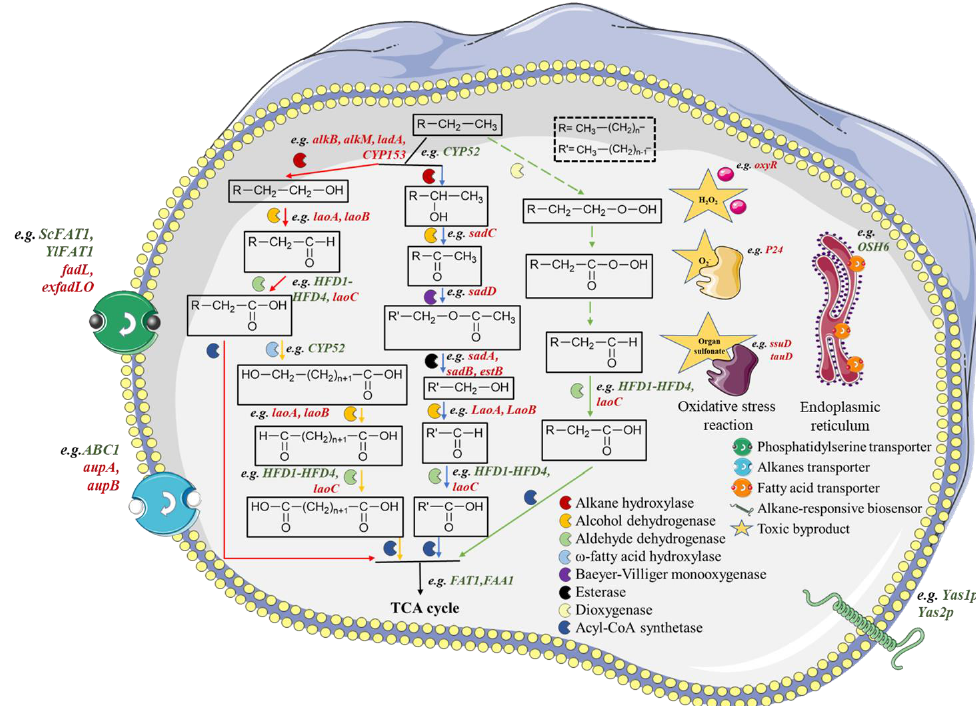
Figure 1. Four pathways for alkane biodegradation. Terminal oxidation, subterminal oxidation, diterminal oxidation, and Finnerty way are indicated by red, blue, orange, and green, respectively. Red italics indicate prokaryotic genes and green italics indicate eukaryotic genes. Dashed lines indicate a putative pathway.